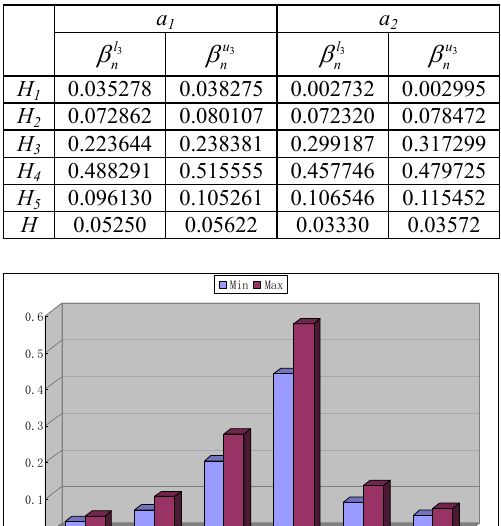
under α = 0.5, 0.7, and 0.9